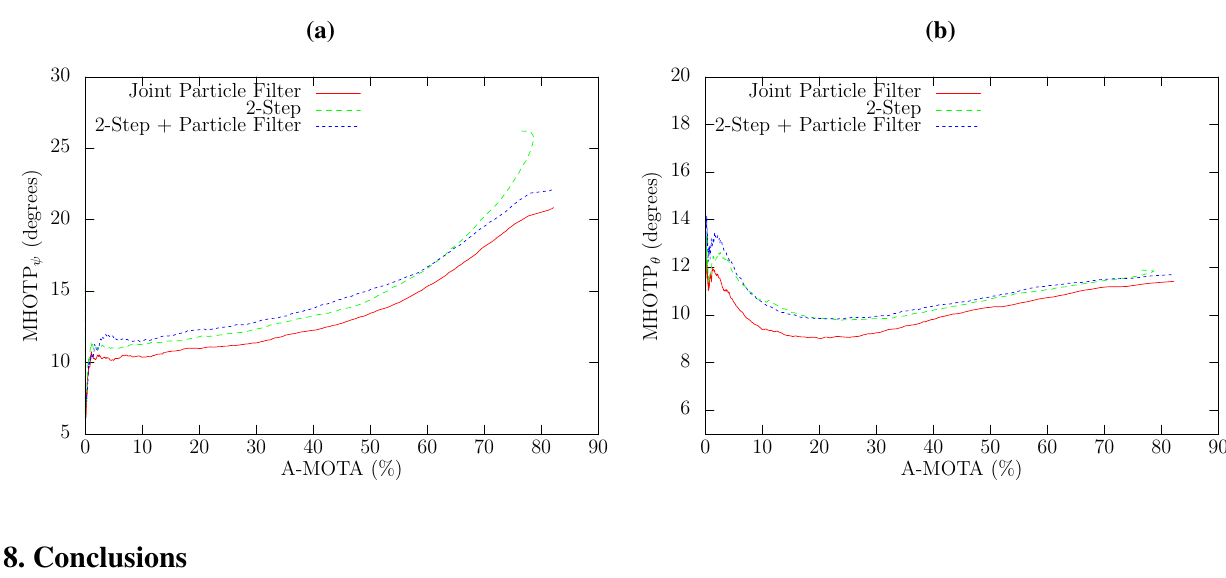
Figure 5. Curve of all possible tracking accuracy (A-MOTA), horizontal orientation angle precision (MHOTP ) (a) and vertical orientation angle precision (MHOTP ψ employing a sweep threshold parameter on the algorithm